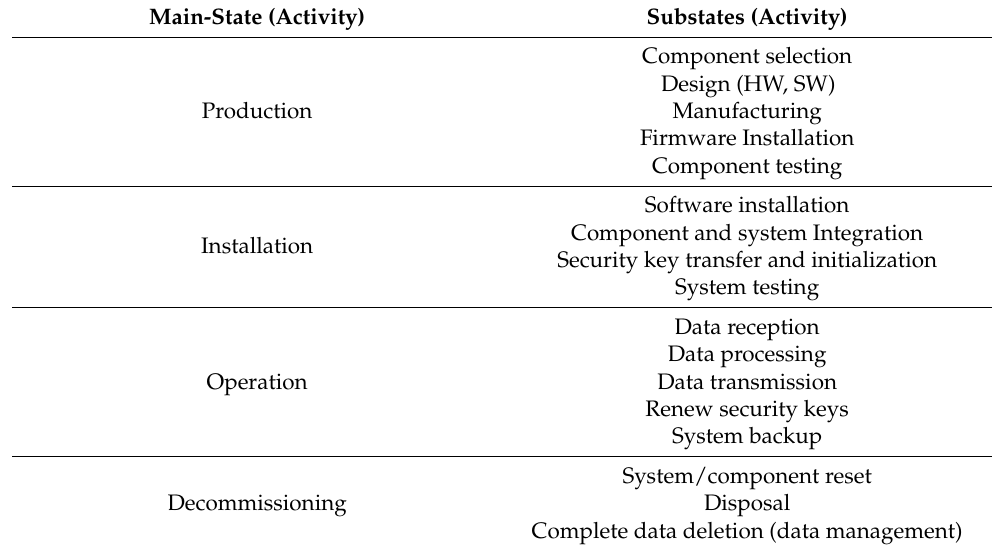
Table 1. System operation